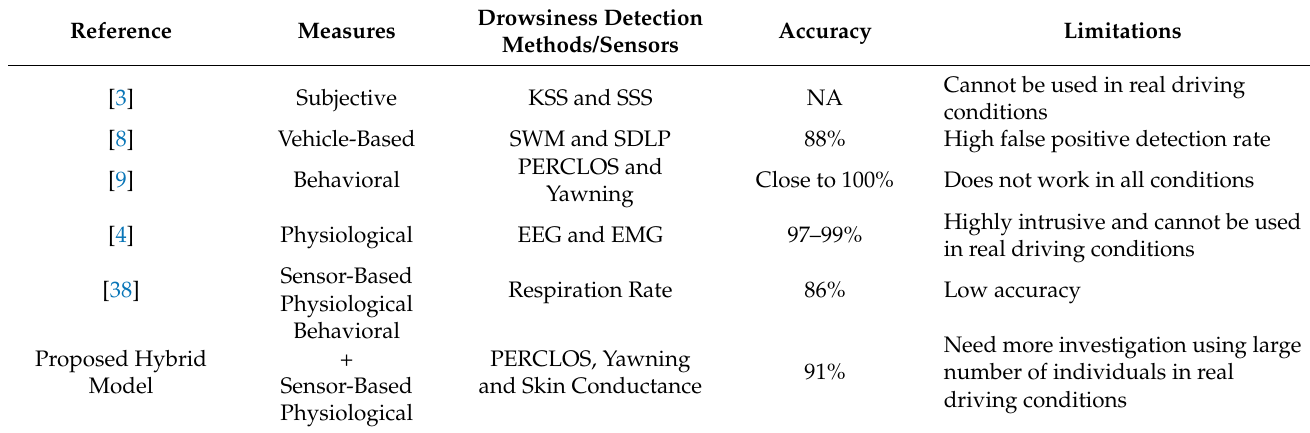
Table 6. Comparison proposed for hybrid model with different